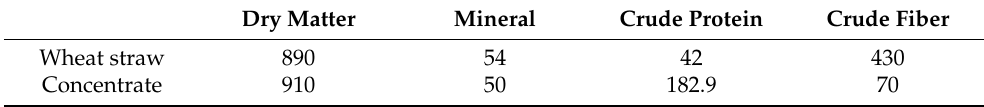
Table 1. Ingredients of the experimental diets and their chemical composition (g/kg fresh matter). Dry Matter Mineral Crude